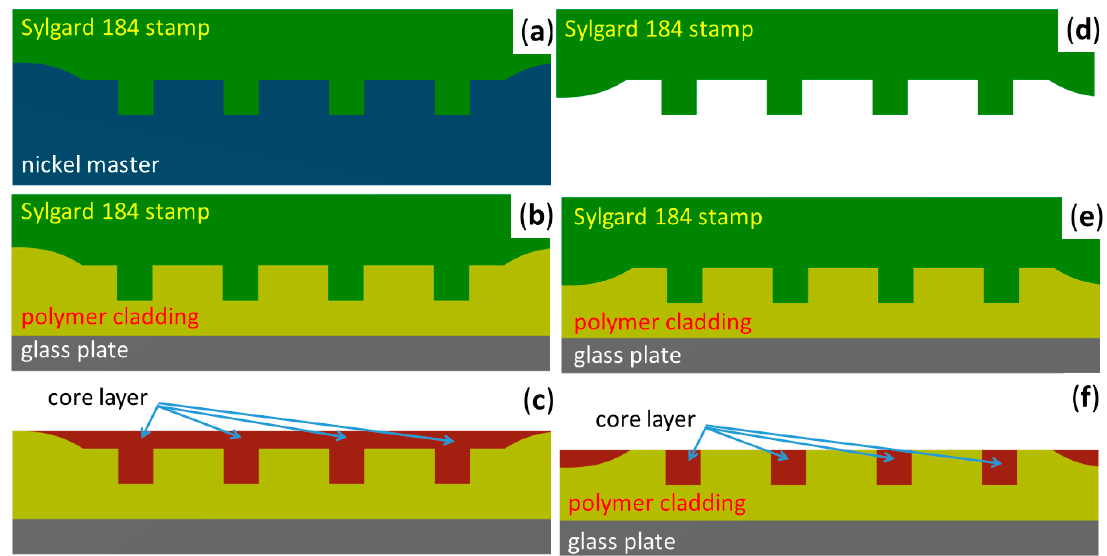
Figure 4. Illustrations of the Sylgard 184 stamp modification process. ( a ) Fabrication of the Sylgard 184 stamp using nickel master, ( b ) fabrication of the U-groove channels using Sylgard 184 stamp, ( c ) filing core polymer layer into U-groove channels, ( d ) modification of the Sylgard 184 stamp, ( e ) fabrication of the U-groove channels using modified Sylgard 184 stamp, ( f ) filing core polymer layer into U-groove channels.